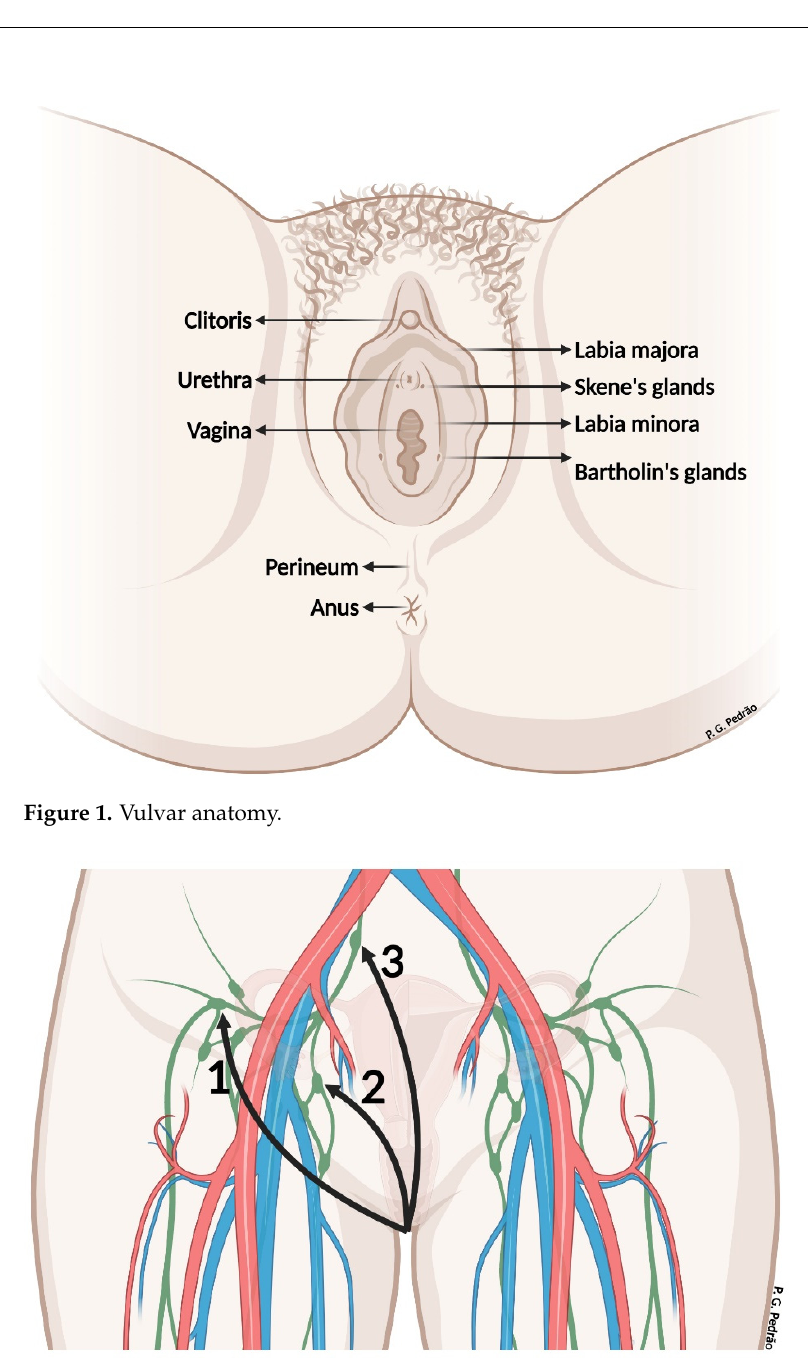
Figure 2. Lymphatic drainage on the vulva. The blue and red colors are the circulatory system, in which the blue color is the venous system and the red color is the arterial system. The green color is the lymphatic system. The numbers (1 to 3) indicate the inguinal lymph nodes of the vulvar lymphatic drainage. Number 1 is the superficial inguinal lymph nodes, number 2 is the deep inguinal lymph nodes, and number 3 is the iliac lymph nodes.